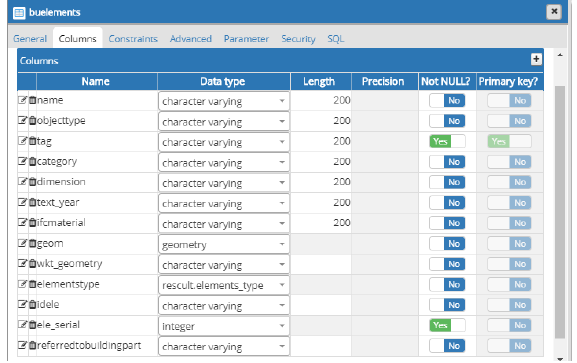
Figure 12. Attributes of the new buelement entity.